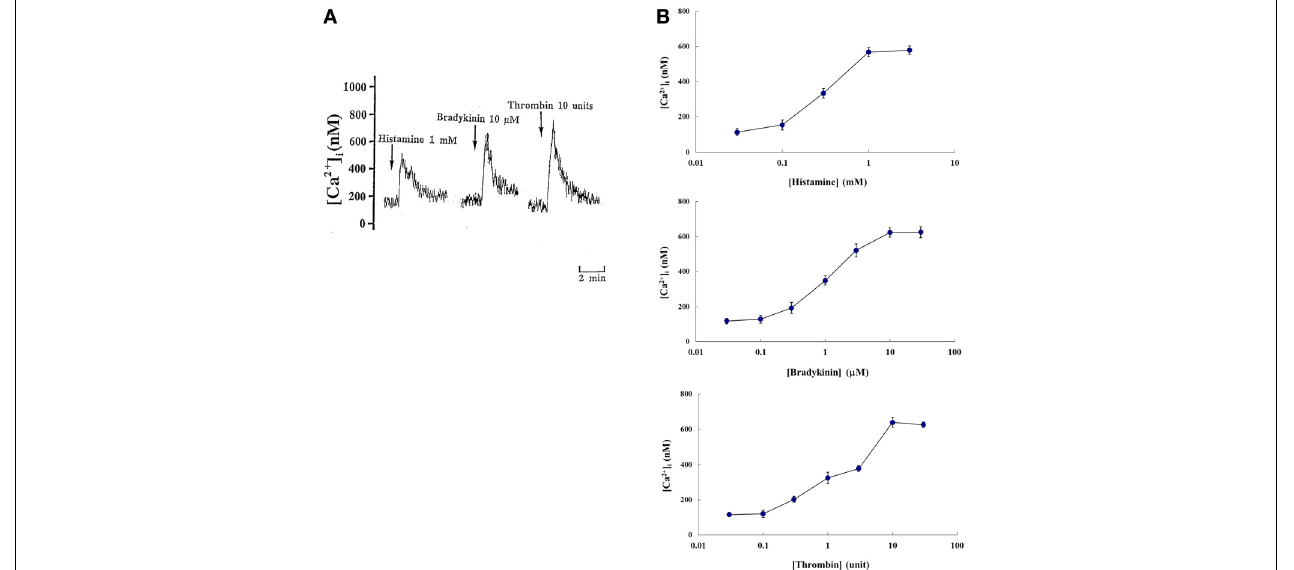
FIGURE 2 | (A) Tracings showing effects of histamine (1mM), bradykinin (10 μ M), and thrombin (10 U) on cytoplasmic Ca 2 + concentration level ([Ca 2 + ] i ) of rat pleural mesothelial cells in the presence of 1.5mM extracellular Ca 2 + . Addition of each agent induced a biphasic elevation of [Ca 2 + ] i : a large initial transient component followed by a sustained